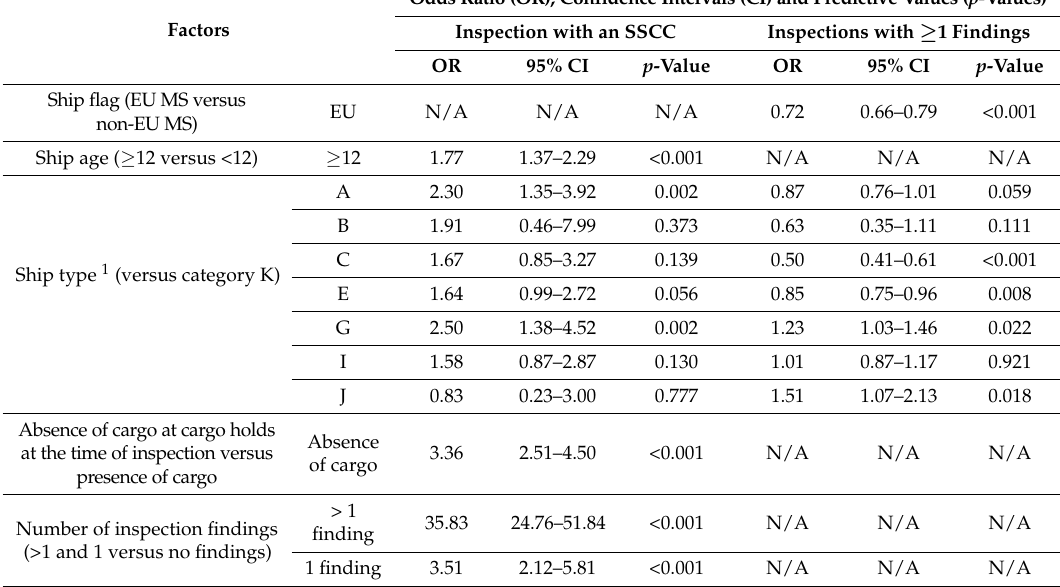
Table 5. Logistic regression analysis of factors in relation to Ship Sanitation Control Certificates (SSCCs) and to the number of inspection